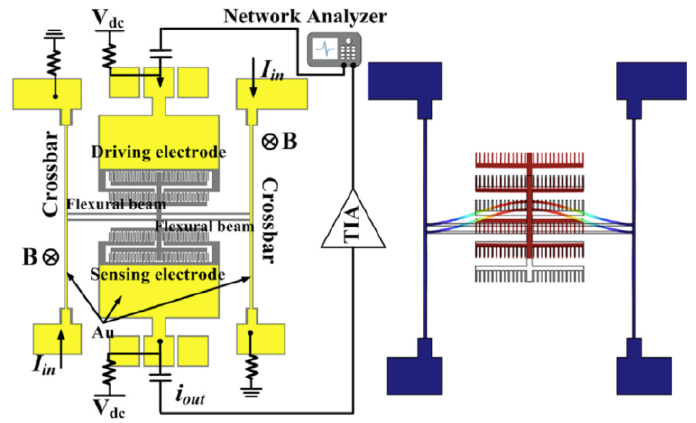
Figure 14. Schematic of a magnetic field sensor formed by a DETF silicon resonator, which considers the bias configuration with a transimpedance amplifier (TIA) at the sensing port. The right side shows the in-phase vibration mode of the DETF resonator [29]. Reprinted with permission from [29]. Copyright© 2014, Elsevier B.V.